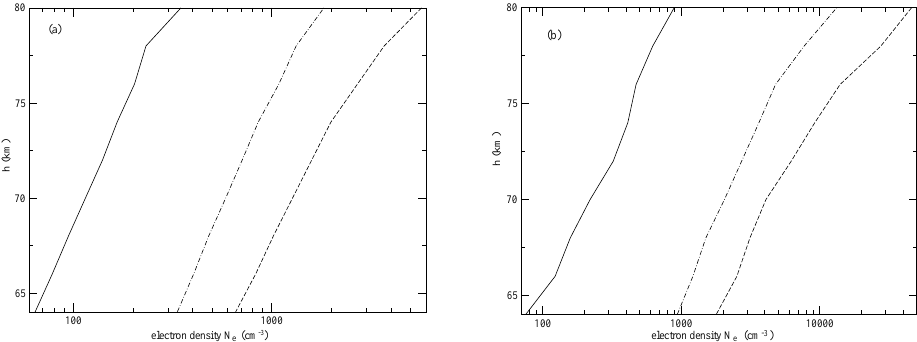
Fig. 7. Altitude profiles of electron density as obtained from GPI model at three different times for an (a) M-class and (b) X-class flare. Solid line shows the ambient profile before the beginning of the flare while the dashed and the dot-dashed lines represent the profile during the peak and at a time during recovery.